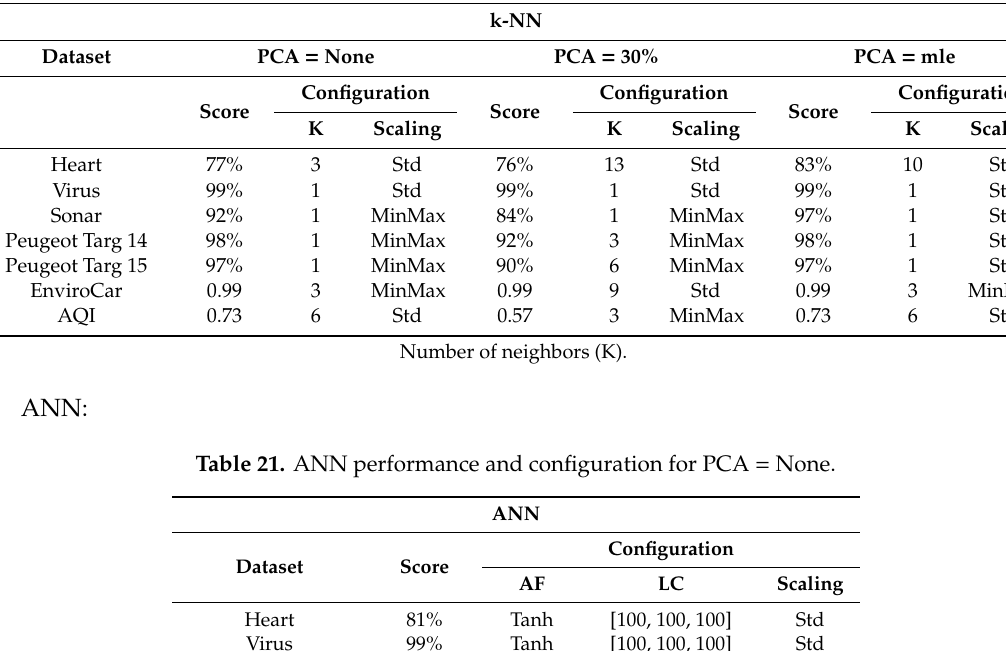
Table 20. k-NN performance and configuration for various PCA techniques.